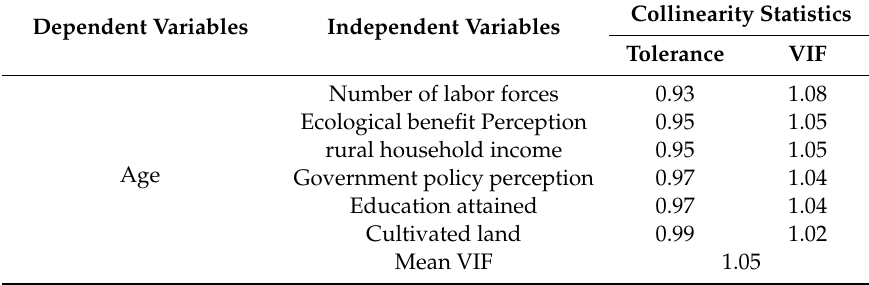
Table 3. Multicollinearity diagnostic results.